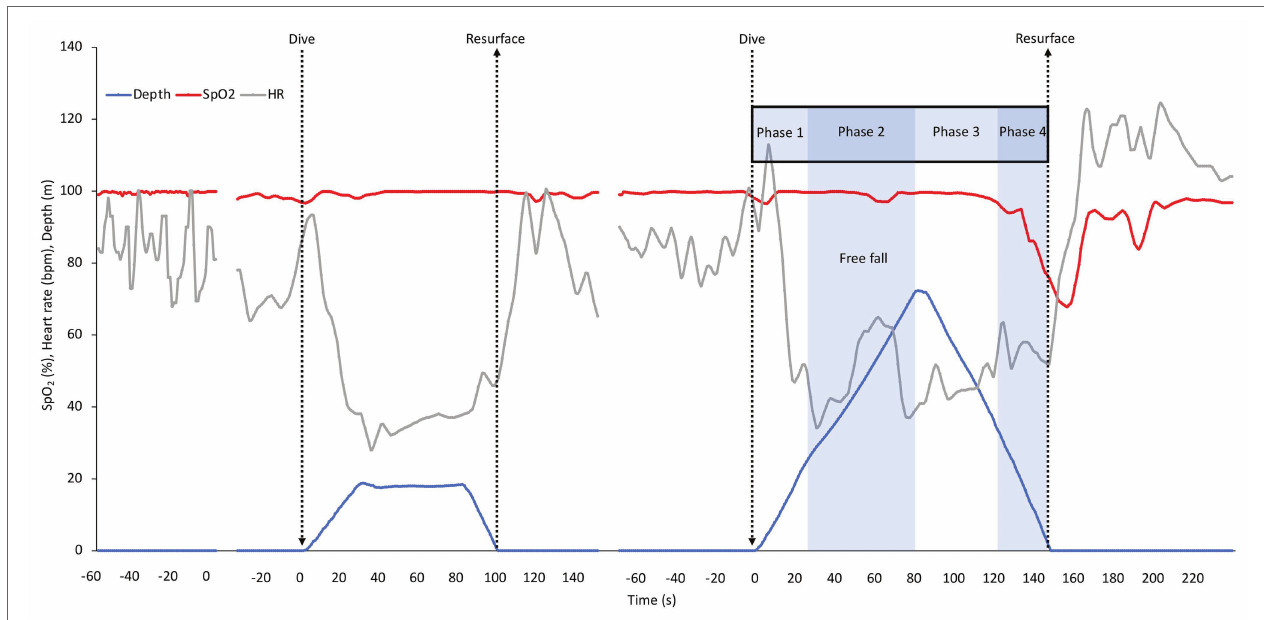
FIGURE 2 | Individual continuous recordings from Diver 1 of arterial oxygen saturation (SpO 2 ), heart rate (HR), and depth during immersion before starting to dive, during the shallow and the deep dive followed by a recovery period. The interruptions represent about 5 min of cut out data. The typical phases of a deep dive are indicated. In a deep dive, i.e., when lungs are compressed below residual volume which for most individuals occurs at greater depth than 30 m, four distinct phases can be identified; (1) a phase of active swimming against positive buoyancy, (2) a passive “free fall” phase when the diver can relax and fall as a result of negative buoyancy, which is after the turn followed by (3) a phase of intense swimming, when the diver actively swims upward against negative buoyancy and (4) the last phase of the dive, when swimming is aided by positive